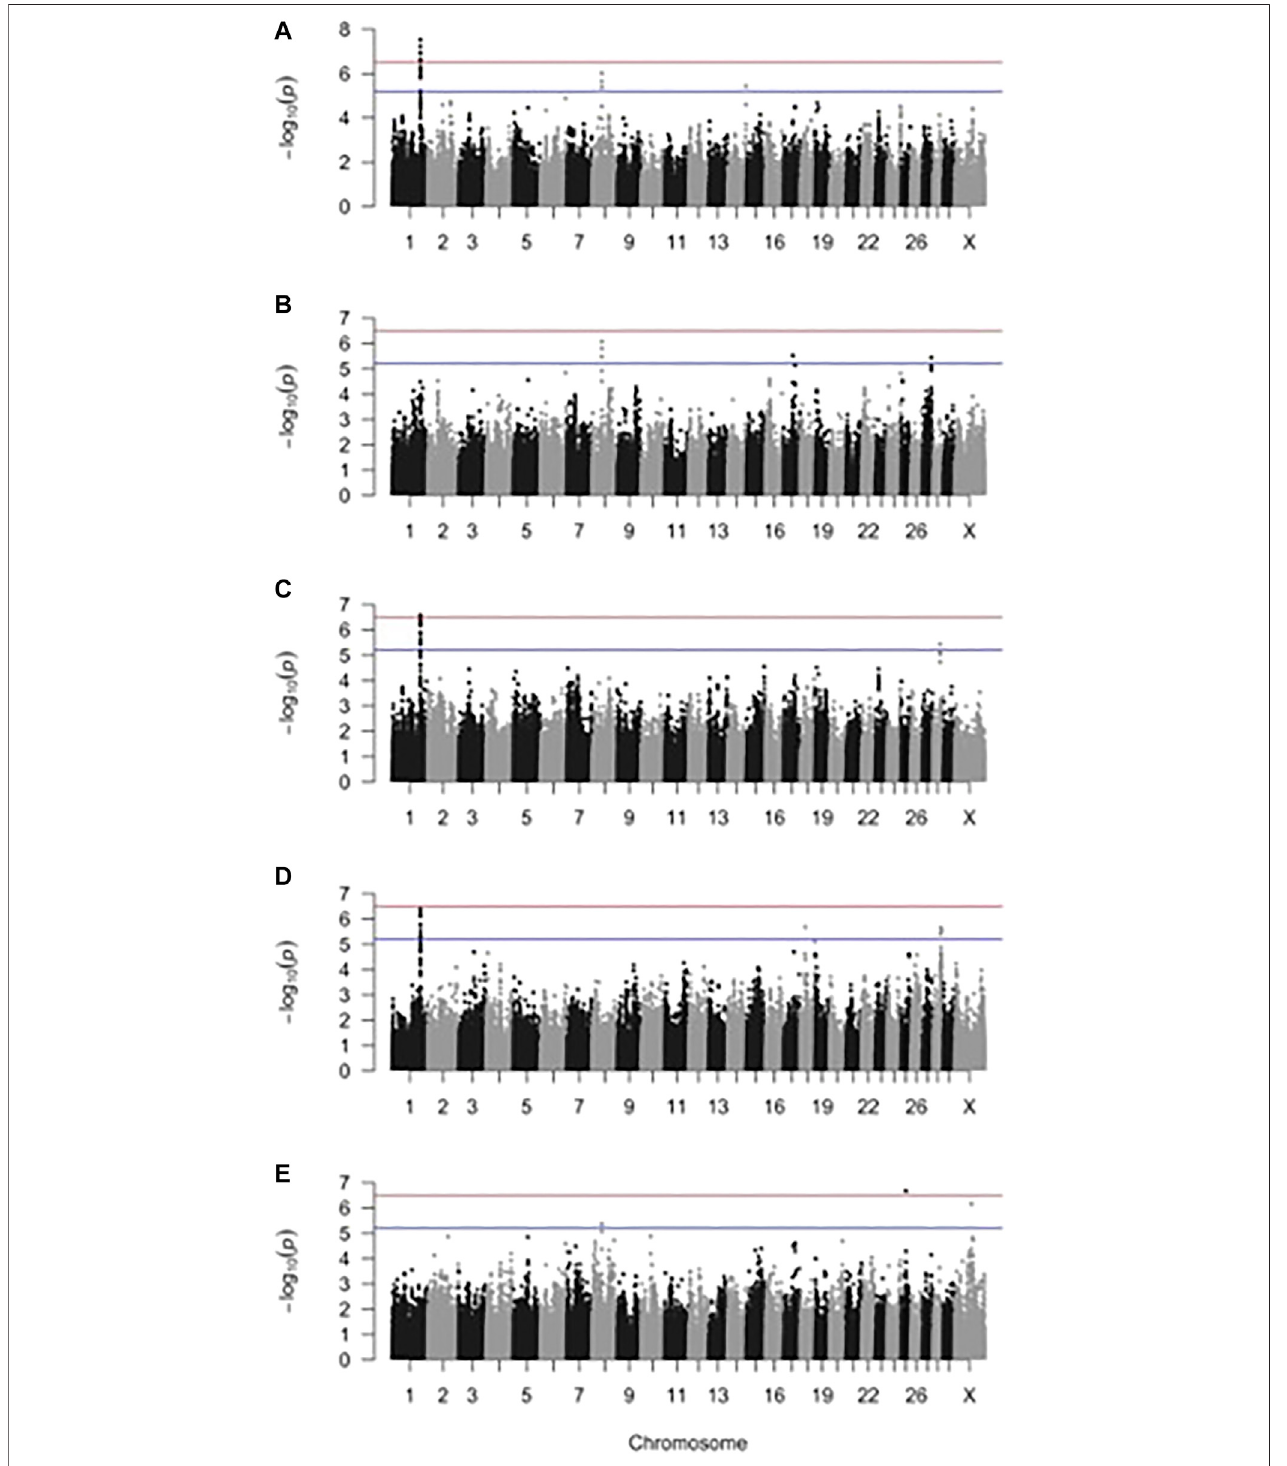
FIGURE2| Manhattanplotfortwo-traitgenome-wideassociationanalysisof (A) soleulcer(SU)anddigitaldermatitis(DD), (B) SUandwhitelinedisease(WLD), (C) DD and mastitis, (D) DD and milk fever, and (E) SU and metritis. The blue line indicates genome-wide suggestive signi fi cance, and the red line indicates genome-wide signi fi